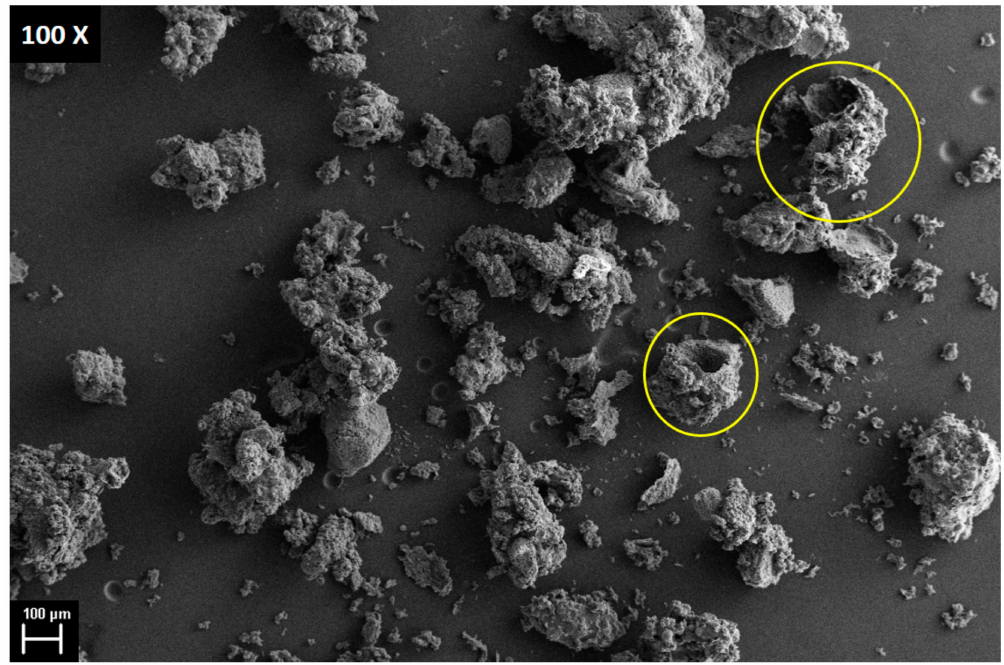
Figure 3. SEM image of particle distribution of washed Char from gasification of Bio50 at 600 ◦ C.